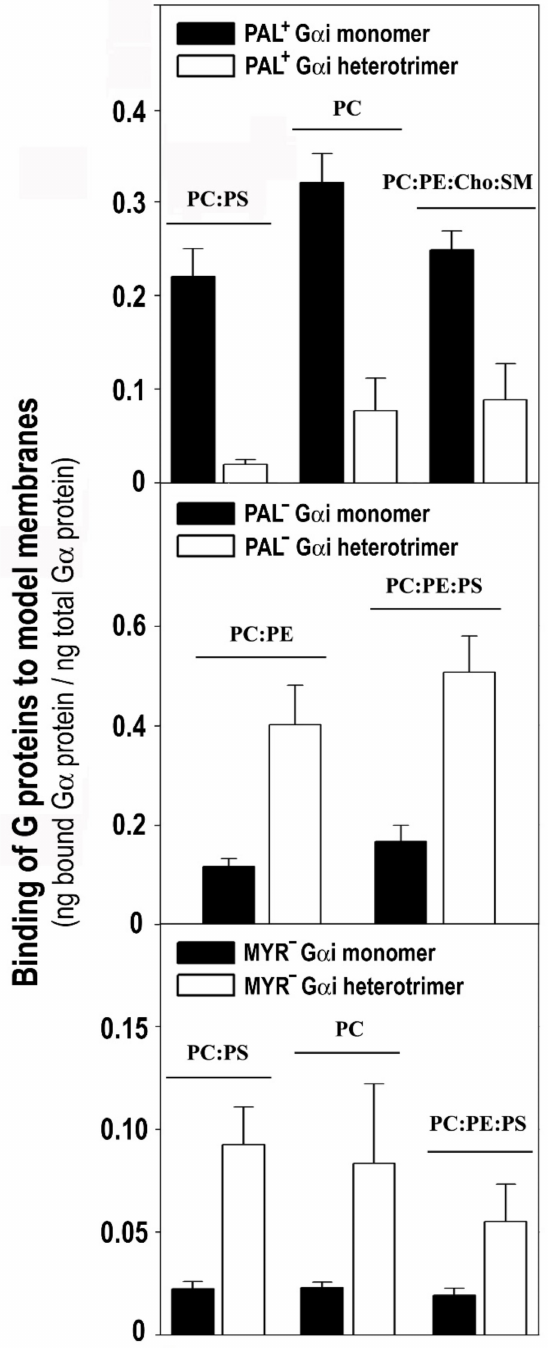
Figure 8. Comparative binding of G α i 1 monomer and G α i 1 β 1 γ 2 trimer to membranes with differ- ent lipid composition. This graph shows the most relevant differences in the membrane-binding properties of the G α i 1 protein in its monomeric and trimeric forms. Upper panel, Comparative binding of monomeric Pal + G α i 1 and trimeric WT G β 1 γ 2 -Pal + G α i 1 complex to PC:PS (3:2, mol:mol), PC and PC:PE:Cho:SM (1:1:1:1, mol:mol). The greatest differences in binding between these Pal + G α i 1 proteins were observed in these cases. Middle panel, Comparative binding of monomeric Pal − G α i 1 and trimeric WT G β 1 γ 2 - Pal − G α i 1 heterotrimer to PC:PE (1:1, mol:mol) and PC:PE:PS (2:2:1, mol:mol). Lower panel, Comparative binding of monomeric Myr − (G2A mutant) G α i 1 and trimeric are mean ± S.E.M. values and in all cases p < 0.05 for each monomer-trimer